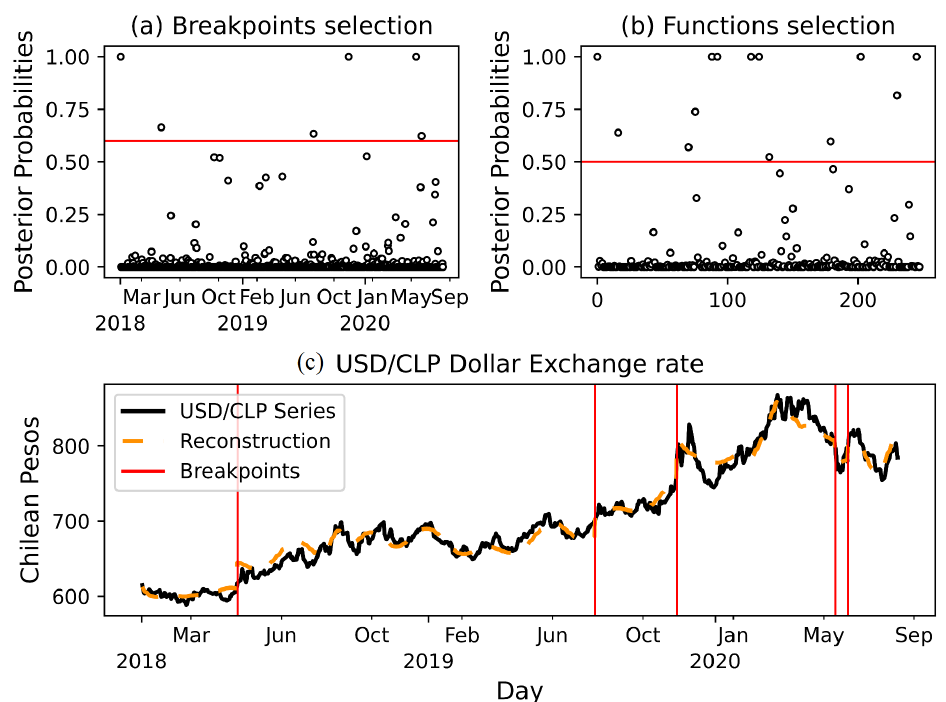
Figure 7. Top : Posterior probabilities for selection of change points ( a ) and functions ( b ) without prior knowledge. Bottom : ( c ) Estimated expectation and change